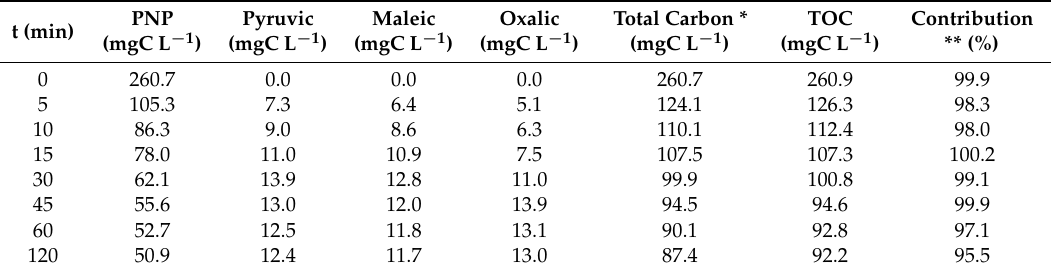
Table 3. p -nitrophenol (PNP) and carboxylic acids concentration along the reaction time under optimized conditions with Fe/XGM as catalyst, total carbon based on such analyzed compounds, experimental total organic carbon (TOC) and carbon